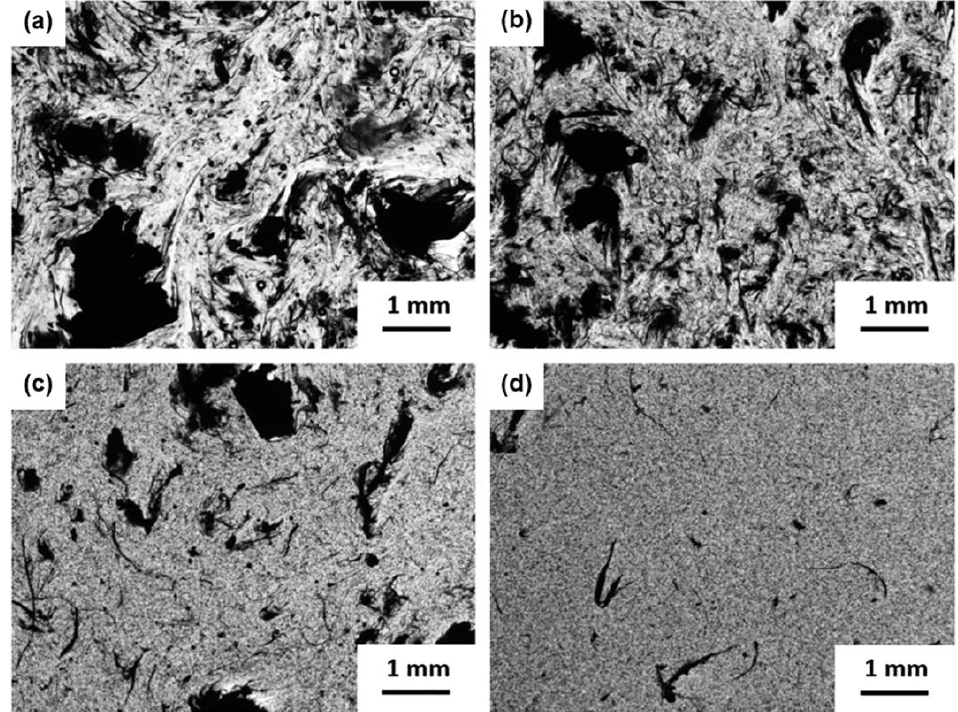
Figure 4. Optical images of ( a ) the epoxy/SWCNT (I d = 0.104 ± 0.007), ( b ) epoxy/GNP 2 SWCNT 8 (I d = 0.108 ± 0.01), ( c ) epoxy/GNP 5 SWCNT 5 (I d = 0.201 ± 0.021) and ( d ) epoxy/GNP 8 SWCNT 2 (I d = 0.443 ± 0.027) mixtures after sonication in ultrasonic bath at 80 °C for 90 min.